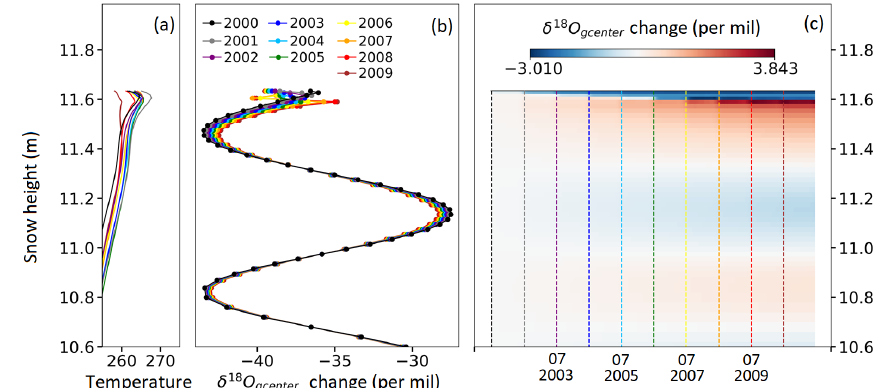
Figure 3. Simulation 2: attenuation of the seasonal δ 18 O gcenter variation caused by diffusion in the vapor phase over 10 years (with temper- ature evolution, original signal with a mean value of − 35 . 5‰ and amplitude of 16‰). (a) Vertical temperature profile for each summer; (b) δ 18 O gcenter profile for each summer; (c) evolution of the deviation to the original profile of δ 18 O gcenter . Note that temperature evolves during the whole year (see Fig. S1).